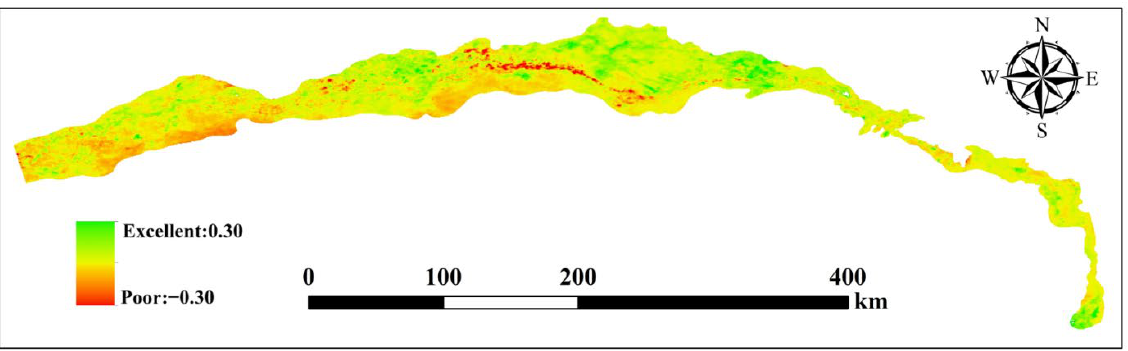
Figure 12. Spatial variations in RSEI values in the mainstream area of the Tarim River from 2015 to 2021.